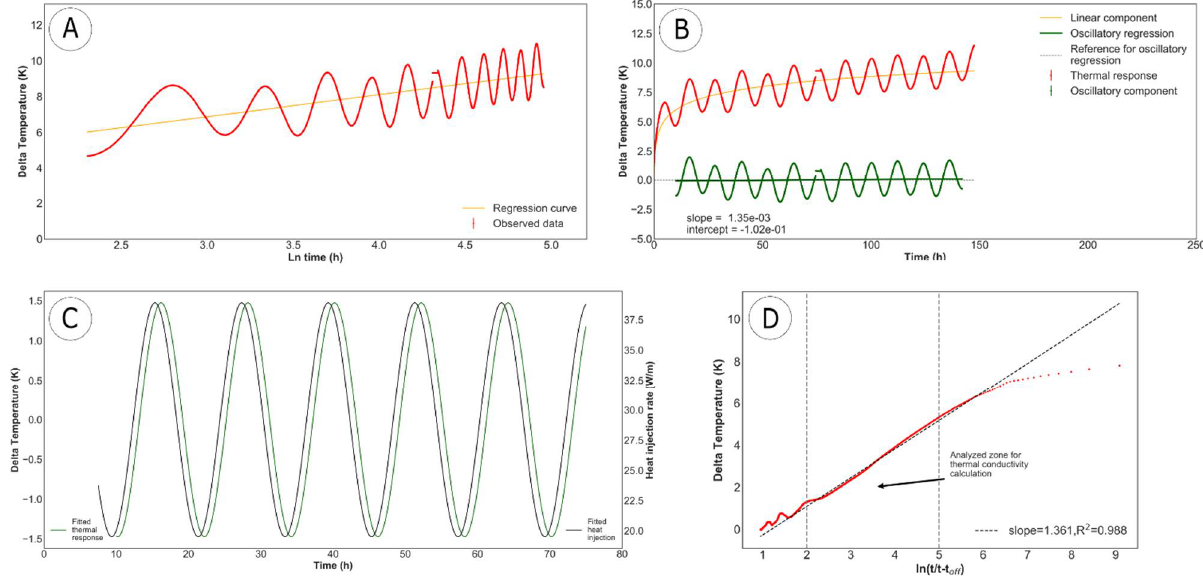
Figure 10. Analysis of the OTRT carried out on the field: ( A ) evaluation of λ heating and R ∗ via the slope method; ( B ) split of the linear and oscillatory components; ( C ) comparison of the oscillatory heat injection and the oscillatory thermal response (the graph is cut at 75 h for simplicity); ( D ) analysis of the recovery period to estimate λ cooling .